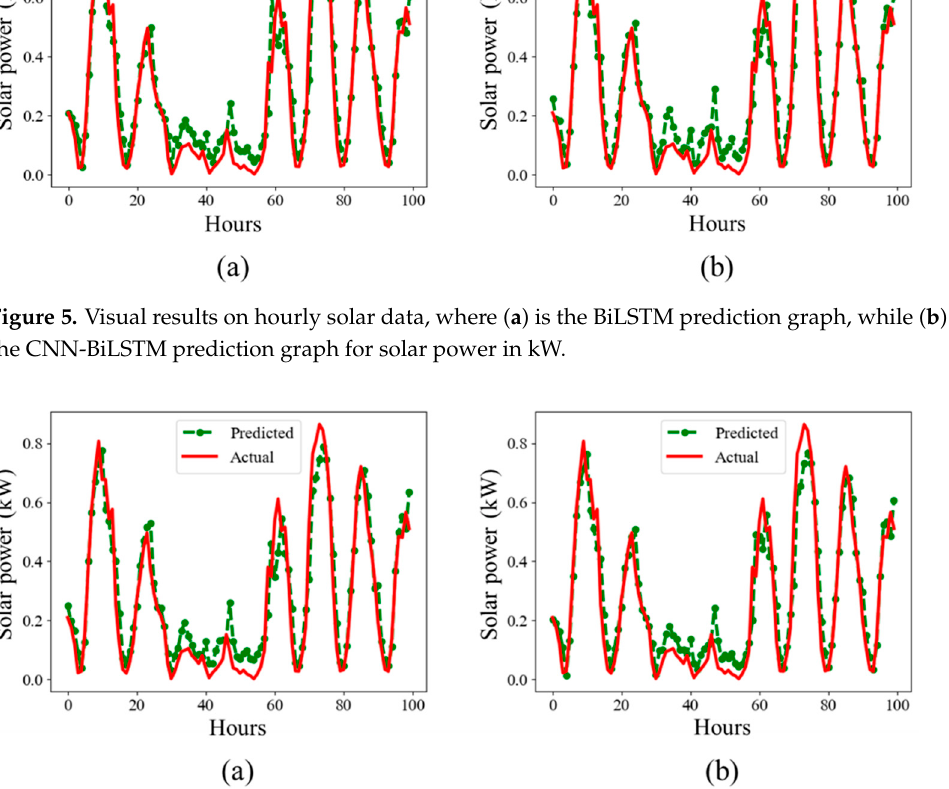
Figure 5. Visual results on hourly solar data, where ( a ) is the BiLSTM prediction graph, while ( b ) is the CNN-BiLSTM prediction graph for solar power in kW.